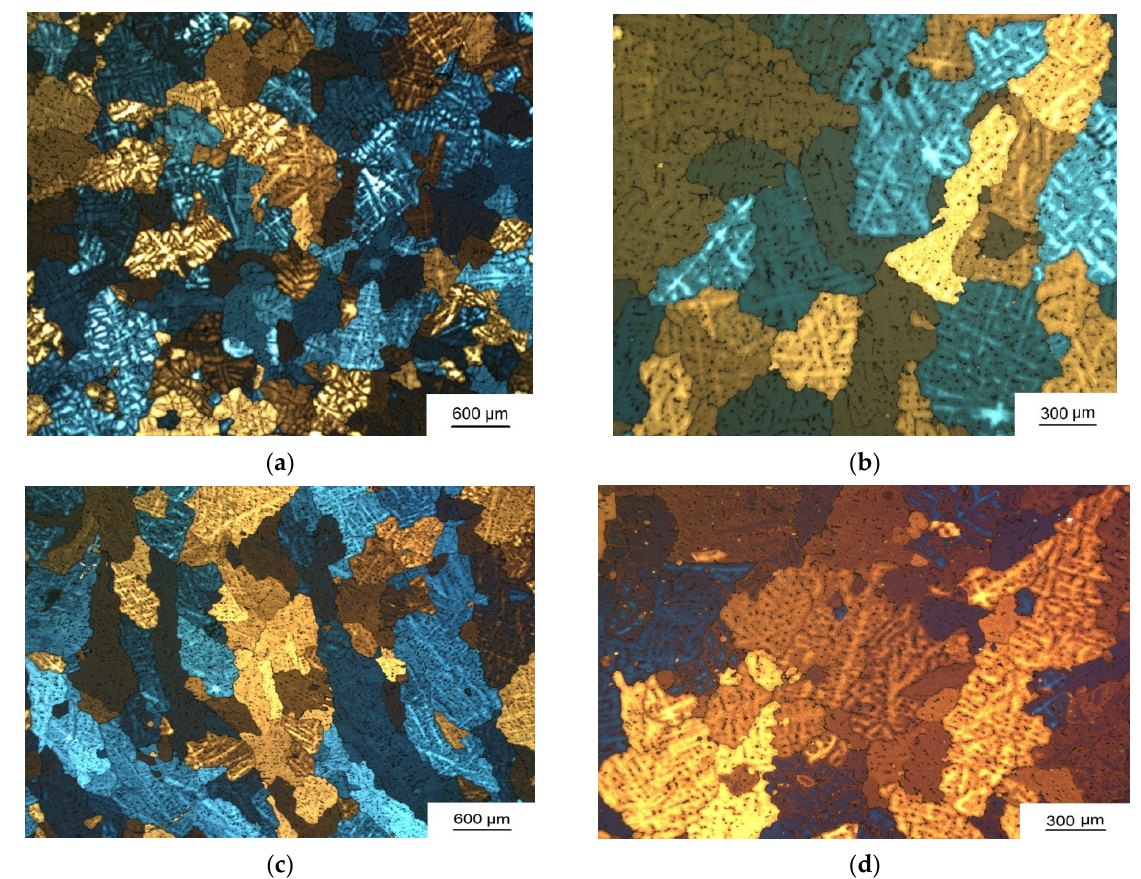
Figure 2. Grain structure after casting ( a ) Al 0.5 Mg 1.3 Si ( b ) Al 0.5 Mg 1.3 Si 0.3 Sc, ( c ) Al 0.5 Mg 1.3 Si 0.3 Zr, ( d ) Al 0.5 Mg 1.3 Si 0.3 Sc 0.15 Zr.